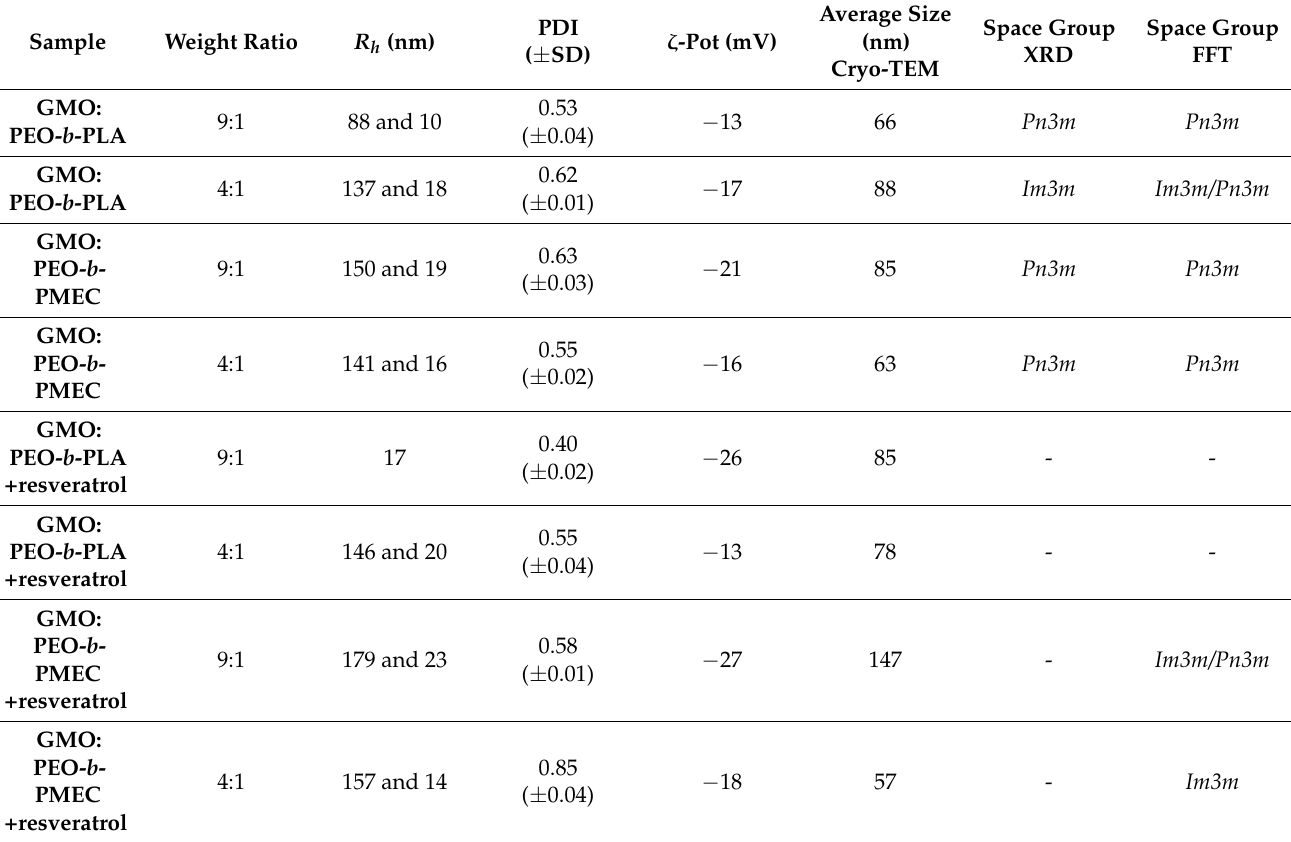
Table 2. Dynamic light scattering, ζ -potential, cryo-TEM histograms, XRD and FFT analysis